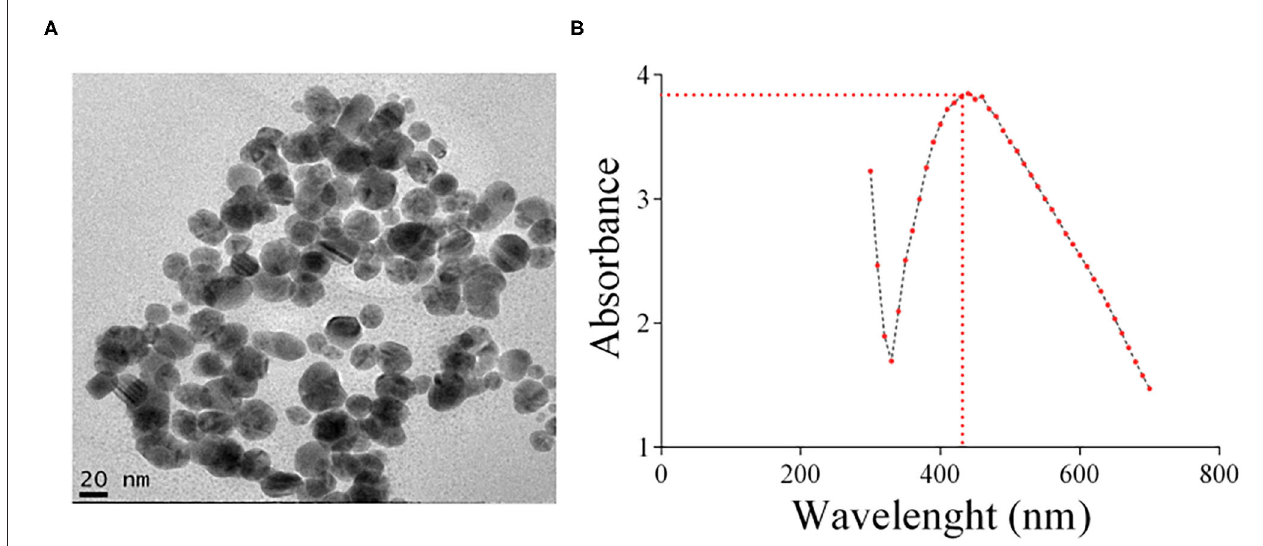
FIGURE 1 | (A) Representative TEM image of the AgNPs prepared and used in this study. (B) UV/VIS absorption spectra of the silver colloid nanoparticles. The absorbance peak of the AgNPs corresponding to the surface plasmon resonance (SPR) of the nanoparticles was 435